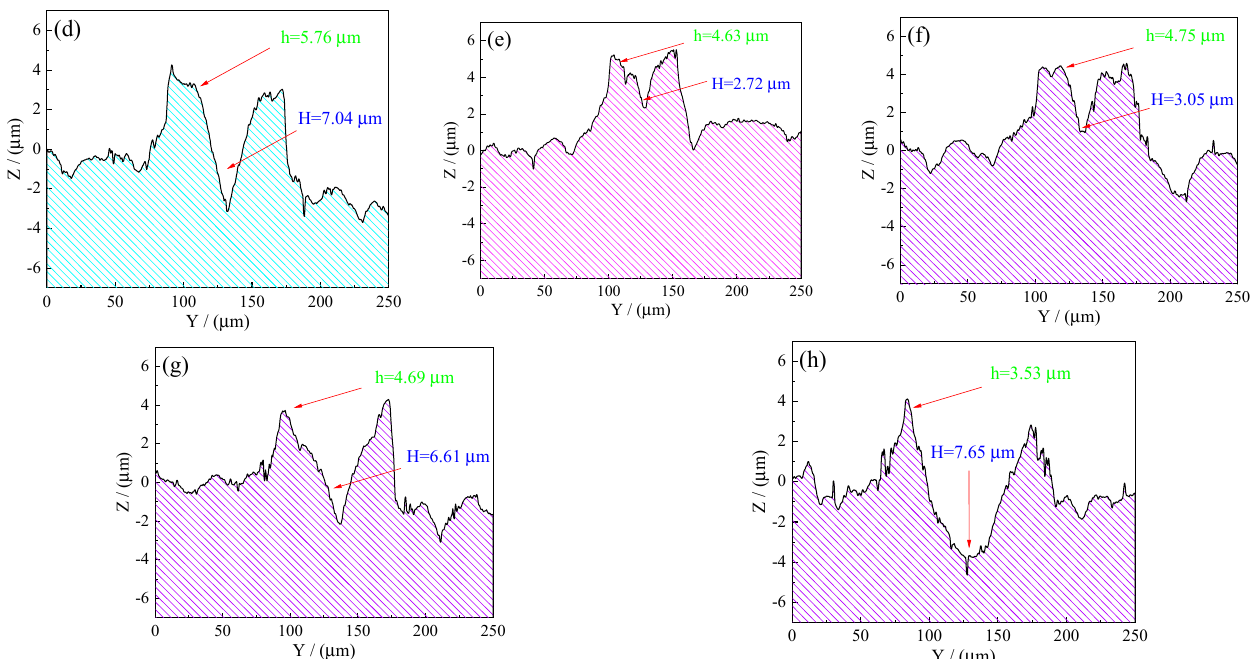
Figure 11. Experimental 2D cross-sectional profiles obtained from Figure 10: ( a ) 75 µs, 50 W; ( b ) 100 µs, 50 W; ( c ) 125 µs, 50 W; ( d ) 150 µs, 50 W; ( e ) 75 µs, 60 W; ( f ) 100 µs, 60 W; ( g ) 125 µs, 60 W; ( h ) 150 µs, 60 W.